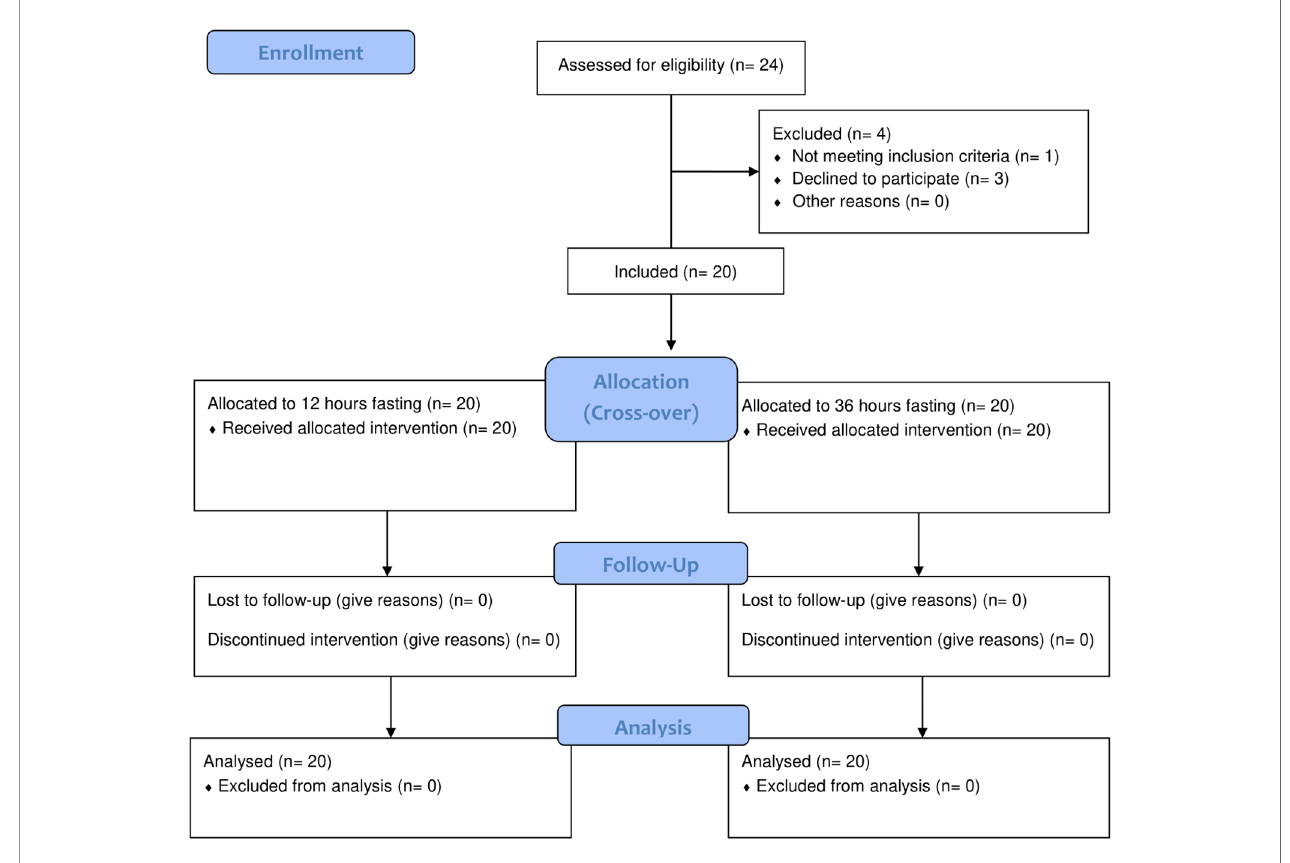
FIGURE 1 | Study fl ow